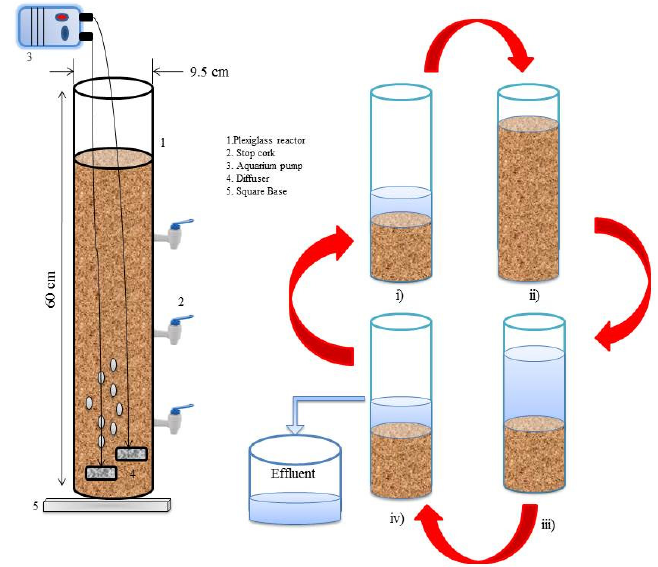
Figure 2. Schematic diagram of Lab scale sequencing batch reactor: ( i ) fill phase ( ii ) react phase ( iii ) settle phase; and ( iv ) decant phase.